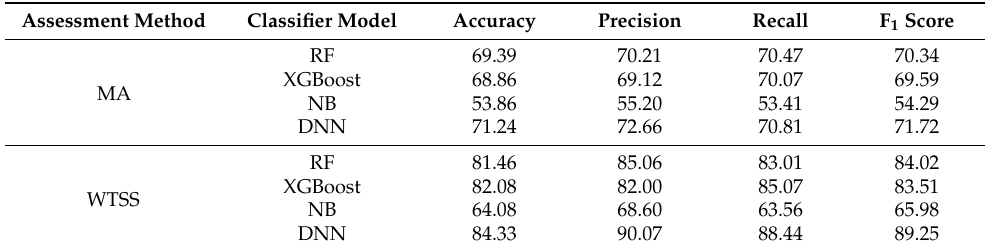
Table 5. Ablation experiment of different injury assessment methods and classifier